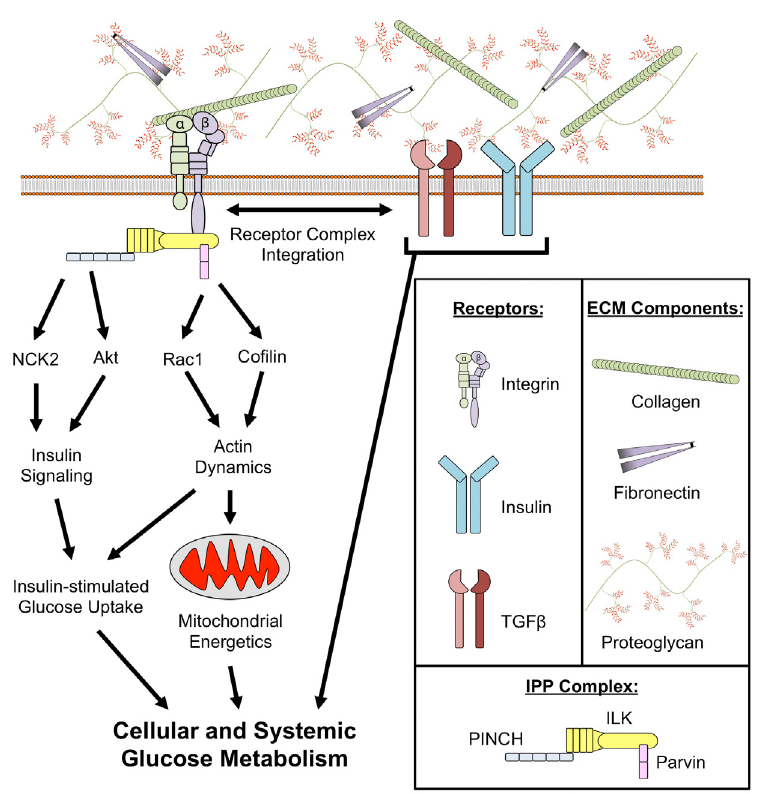
Figure 2. Putative mechanisms for the role of integrins in the development of insulin resistance. Extracellular matrix (ECM) proteins are ligands for integrins, a family of cell surface receptors. Integrins are linked to the regulation of glucose metabolism through numerous mechanisms. Integrins can co-localize with transforming growth factor beta (TGF β ) and insulin receptors that are key regulators of glucose uptake into tissues. Integrins are also involved in intracellular signaling through the integrin-linked kinase (ILK)/PINCH/Parvin (IPP) complex. PINCH is characterized as a modulator of kinase signaling pathways as it regulates Nck2 and Akt, requisite proteins for insulin signaling. Parvin is involved in the regulation of cytoskeletal dynamics that permit remodeling and translocation of mitochondria and various intracellular proteins (that is, glucose transporters). The integration of integrins with regulatory nodes for glucose metabolism highlights the potential significance of ECM-integrin signaling in the etiology of insulin